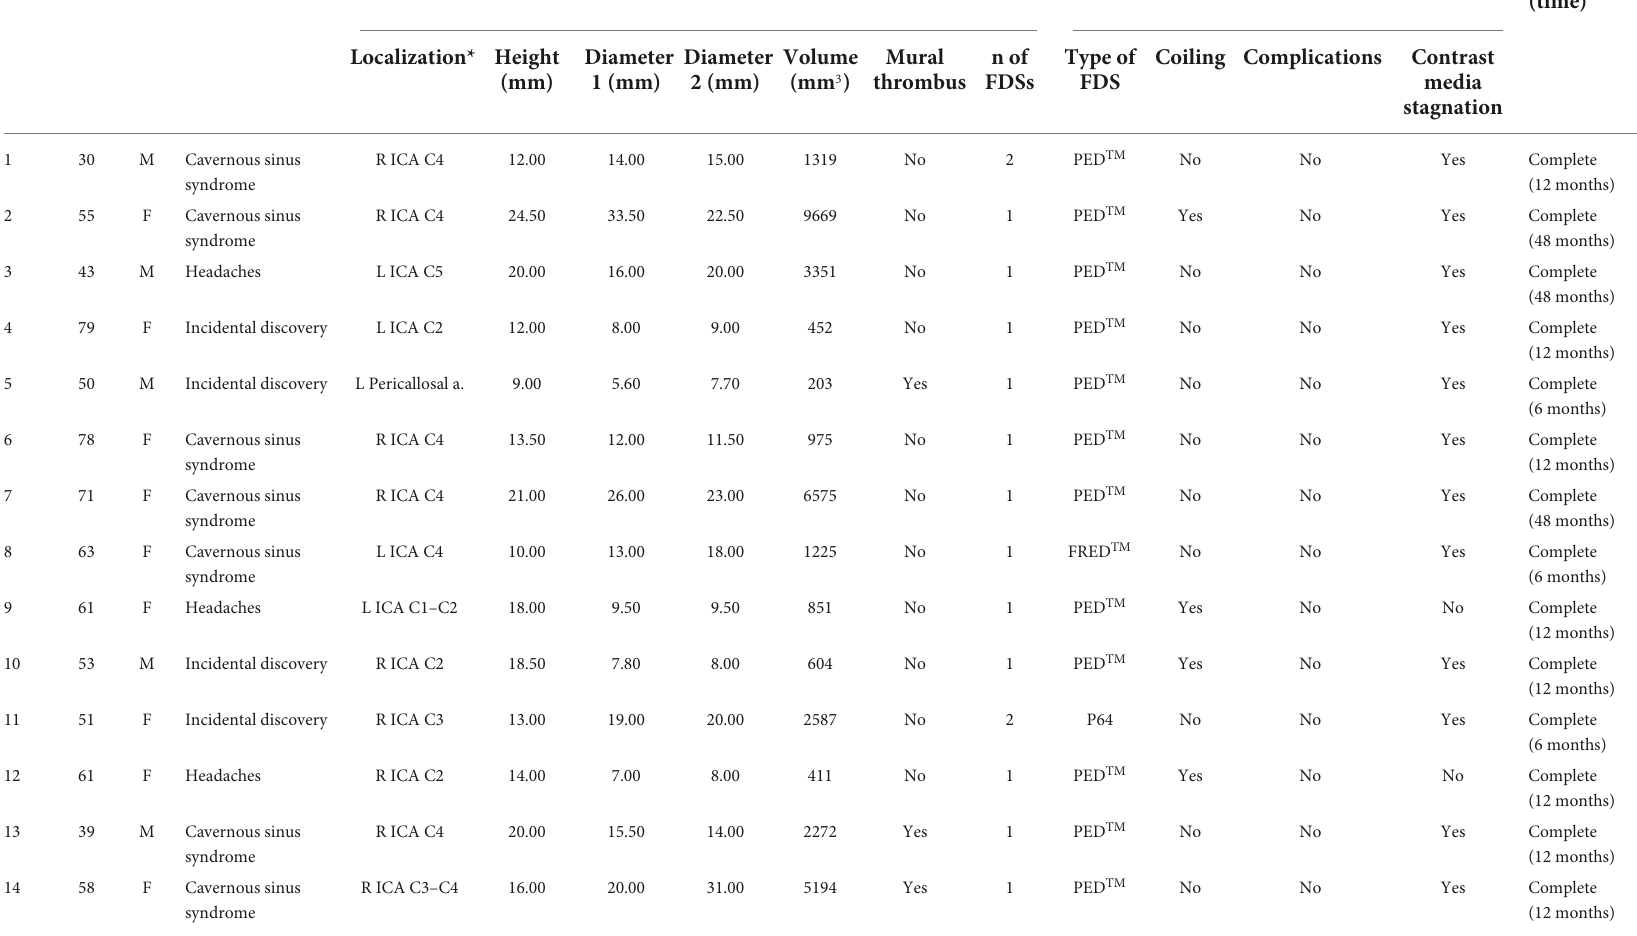
TABLE 1 Population and aneurysm characteristics, procedural features, and